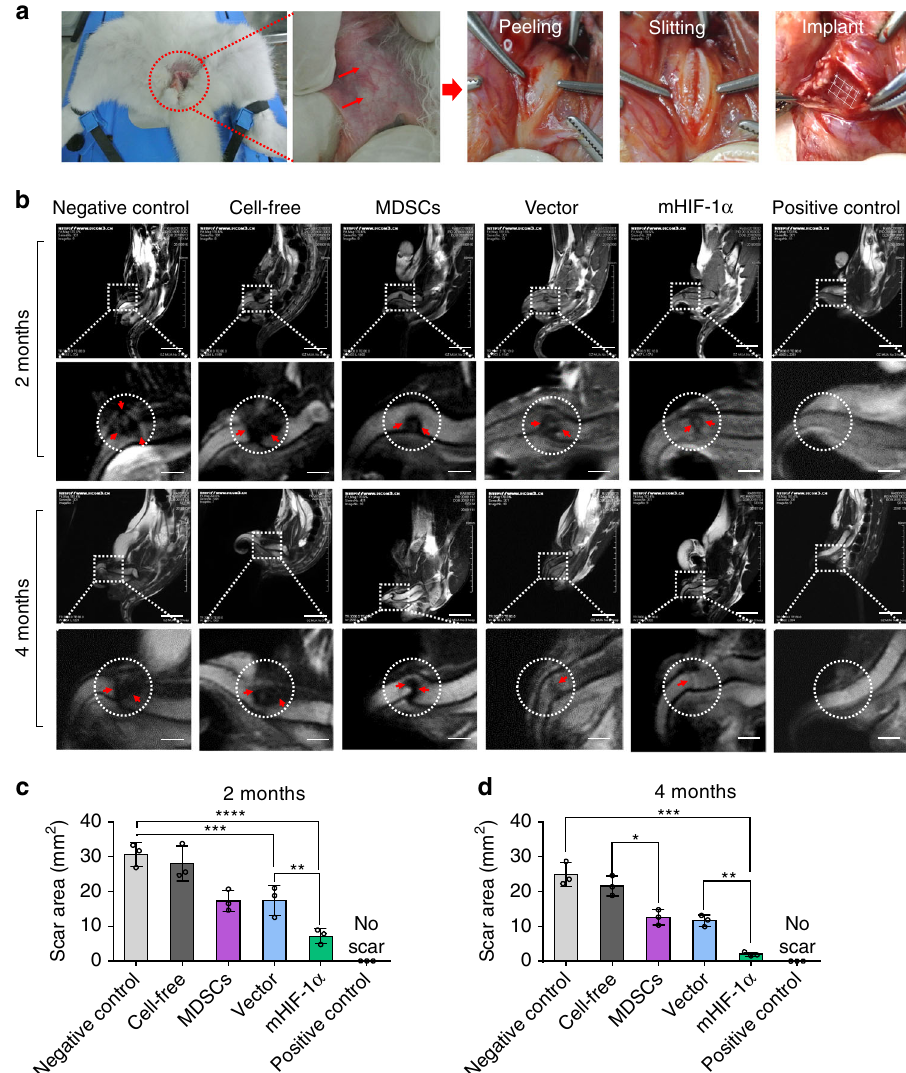
Fig. 4 Establishment of a rabbit model of cavernosum injury and MRI examination. a Surgical process of implanting cell-free and cell-loaded heparin- coated 3D hydrogel scaffolds to repair injured cavernosum. b MRI images showing fi ve different implantation groups (negative control, cell-free, MDSCs, vector and mHIF-1 α ) of the cavernosum scar area (marked as red arrows in a circle) 2 and 4 months after implantation and positive control group showing equal MRI signal. (The scale bar is 20 mm in upper images at low magni fi cation and 5 mm in lower images at high magni fi cation.) c , d Statistical chart of the scar area in ( b ) on month 2 ( c ) and month 4 ( d ) post implantation ( n = 3). Data are displayed as mean ± SD and analysed by two-way ANOVA with Sidak's multiple comparisons test in ( c ) (** p = 0.0028; *** p = 0.0001; **** p < 0.0001) and d (* p = 0.0108; ** p = 0.0055; *** p =